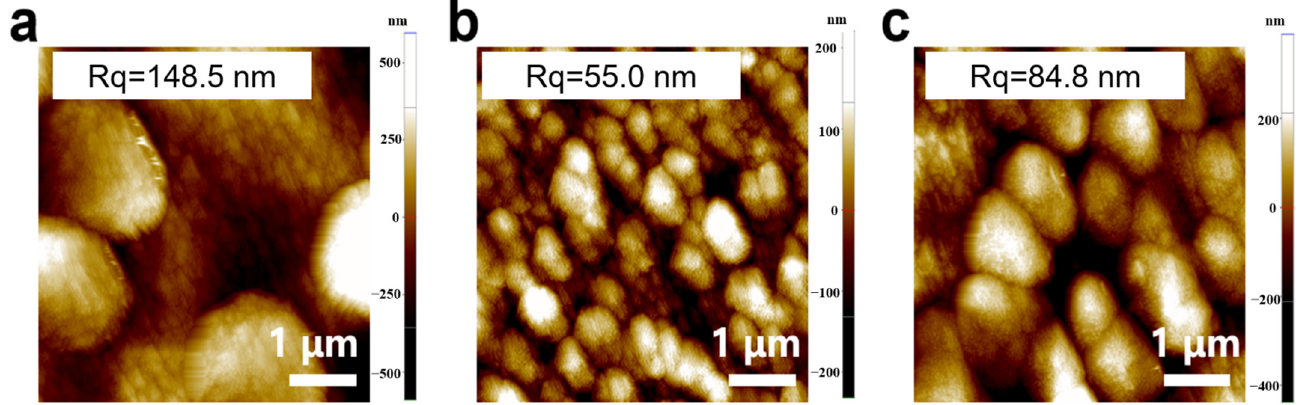
Figure 5. AFM images of copper-based electrodes: ( a ) Cu 0 , ( b ) Cu 0.6 , ( c ) Cu 1.2 .